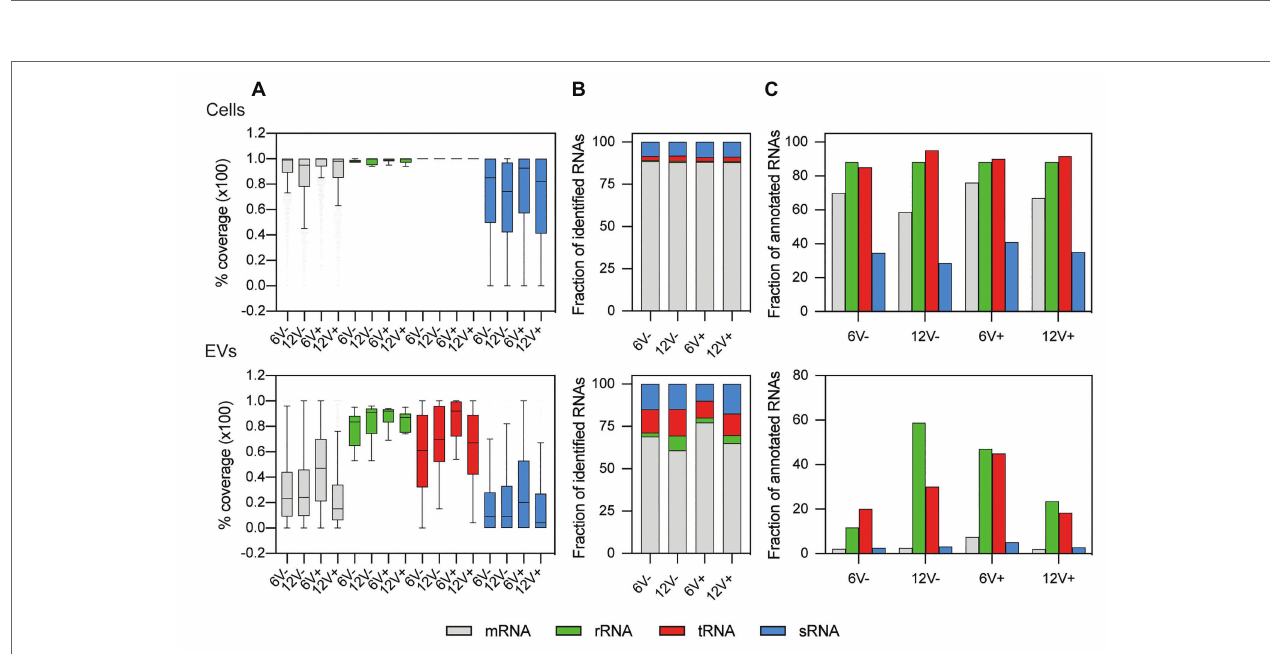
FIGURE 3 | Relative composition of highly covered RNAs from S. aureus HG003 and its secreted EVs. Colors represent the relative amount of each RNA class. (A) Percentage of RNA median coverage. Distribution of newly filtered RNAs with ≥ 90% coverage were plotted for (B) mapped reads (C) and annotated RNA. Number of reads have been normalized with EdgeR. RNA classes are defined from the S. aureus genome annotation NCTC 8325/HG003. Early- and late-stationary growth phases (6 and 12, respectively) in absence (V − ) or presence (V+) of